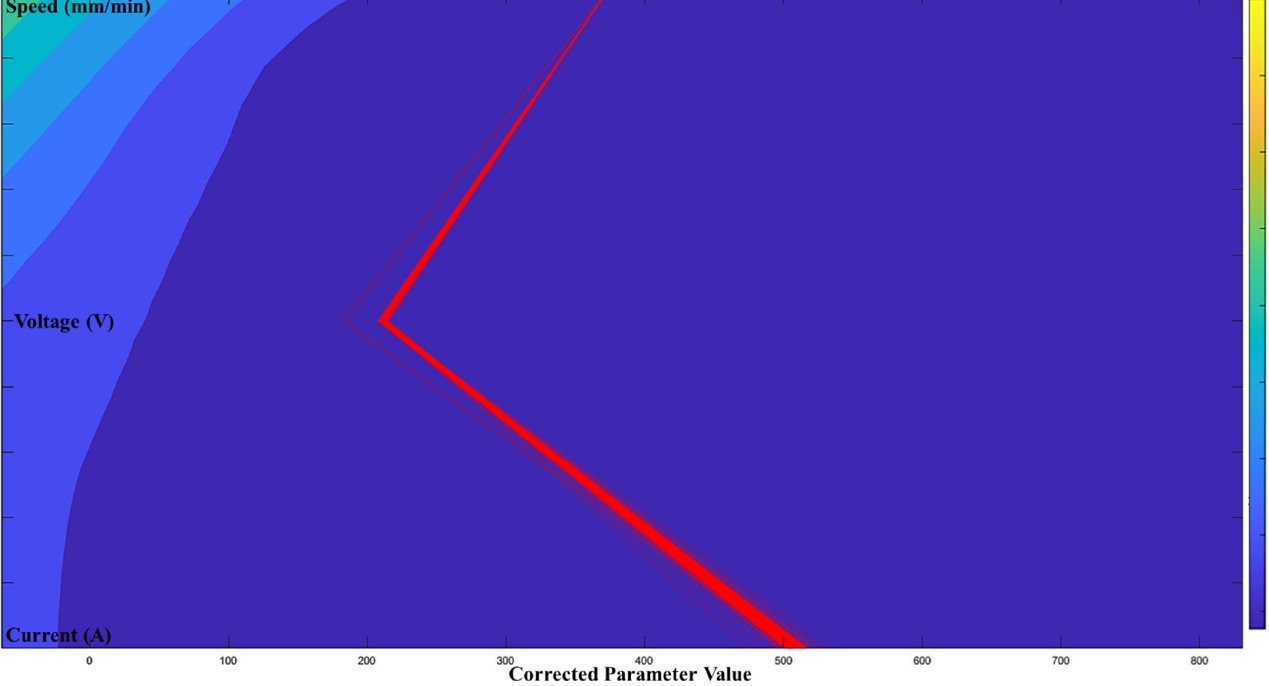
Figure 12. Optimal printable parameters for controlling DOP = 2.5 mm in a 98% confidence interval.